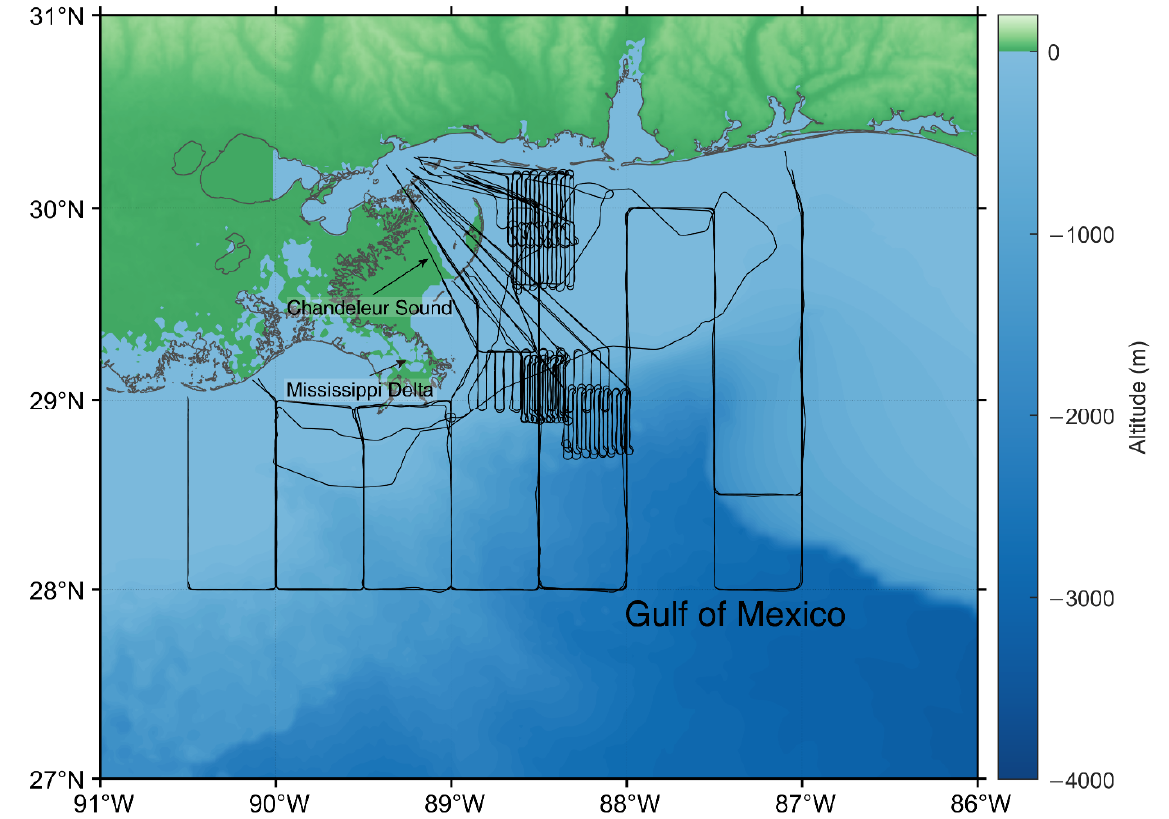
Figure 1. The flight route map for the airborne lidar detection in the northern Gulf of Mexico.